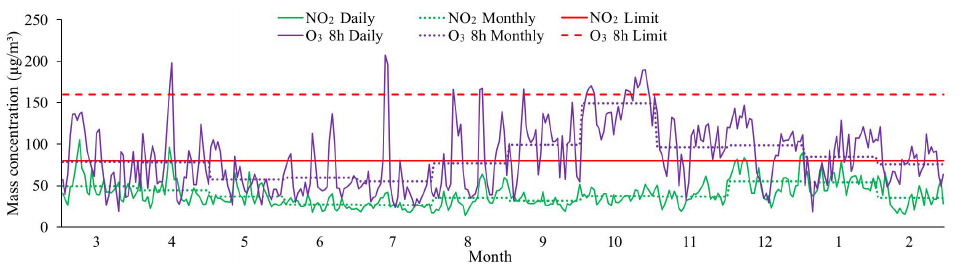
Figure 3. Variation of mass concentration of NO 2 and O 3 8 h in Shenzhen from March 2013 to February 2014.